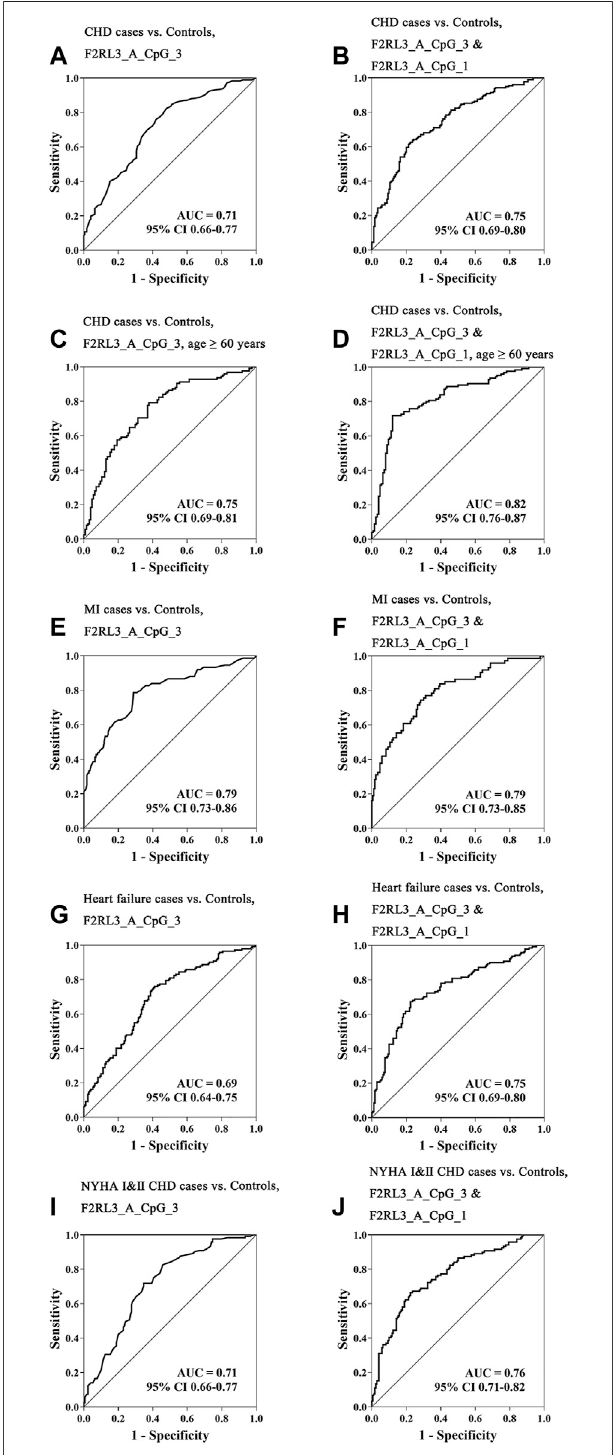
FIGURE 3 | The methylation level of F2RL3 in the peripheral blood DNA asamarkerforthedetectionofCHDingeneral,age ≥ 60 yearsCHDcases,MI cases, heartfailure cases, and patients withminor tomedium cardiac function impairment (NYHA Ⅰ & Ⅱ CHD cases). (A,C,E,G,I) ROC curve analyses for the discriminatory power of F2RL3_A_CpG_3 methylation to distinguish CHD